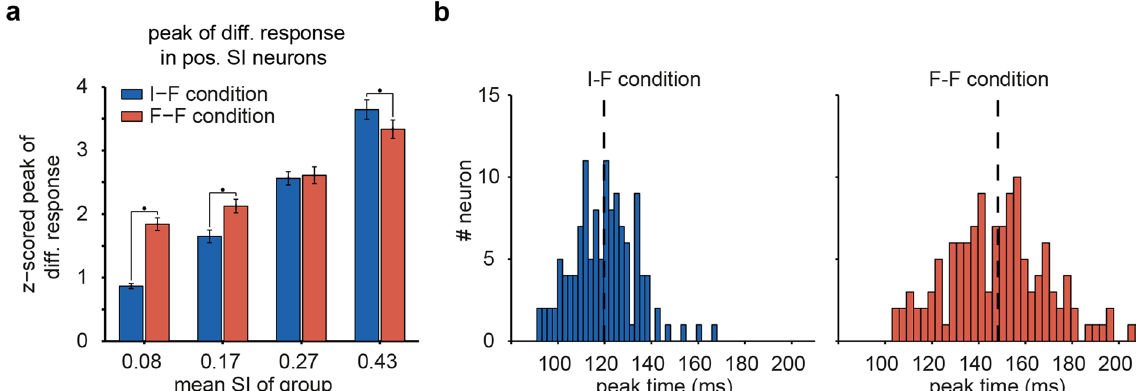
Figure 2. Peak value and peak time of pos. SI neurons under adaptation and non-adaptation conditions. ( a ) Peak value of the differential responses of pos. SI neurons that are divided into four equal-sized groups. The stars show the significance of differences between the F-F and I-F conditions (paired t-test, p < 0.05). ( b ) Distribution of the differential response peak time under the non-adaptation (left, I-F) and the adaptation (right, F-F) conditions for pos. SI neurons, where only neurons with robust estimation of peak time were considered (see Methods). The black dashed line indicates the mean of